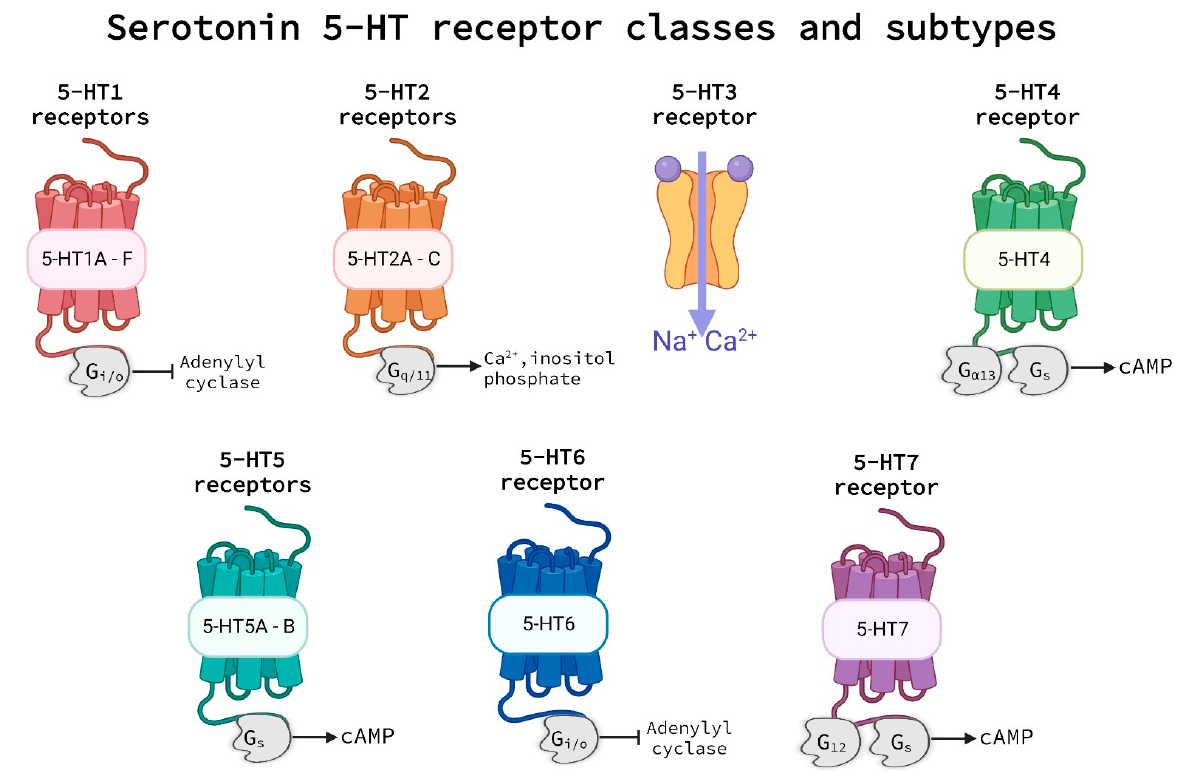
Figure 3. 5-HT receptor groups and subtypes. All 5-HT receptors are G-protein coupled receptors with the exception of the 5-HT3 receptor, which is a ligand-gated channel. Serotonin binds to the 5-HT receptors outside of the cell triggering effector events via various G-protein-triggered signaling